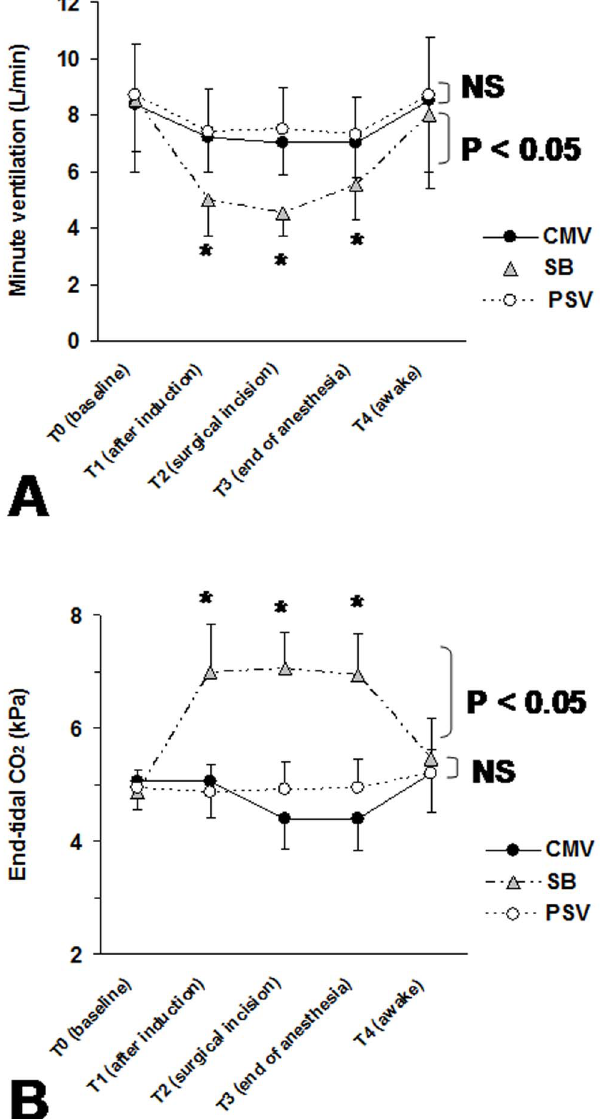
Fig. 4. Minute ventilation and end-tidal CO2 during the study periods. ( A ) minute ventilation and ( B ) end- tidal CO2 (Pet CO2 ) at baseline (T0: before general anesthesia induction), 10 min after general anesthesia induction (T1), at the surgical incision (T2), at the end of anaesthetic drugs infusion (T3) and when the patient was totally awake (T4) obtained for the three groups: CMV-group (Controlled Mechanical Ventilation), SB- group (Spontaneous Breathing) and PSV-group (Pressure Support Ventilation). Data are expressed as mean ¡ SD. P value refers to between-groups comparison. * P , 0.05 versus baseline values, NS: not